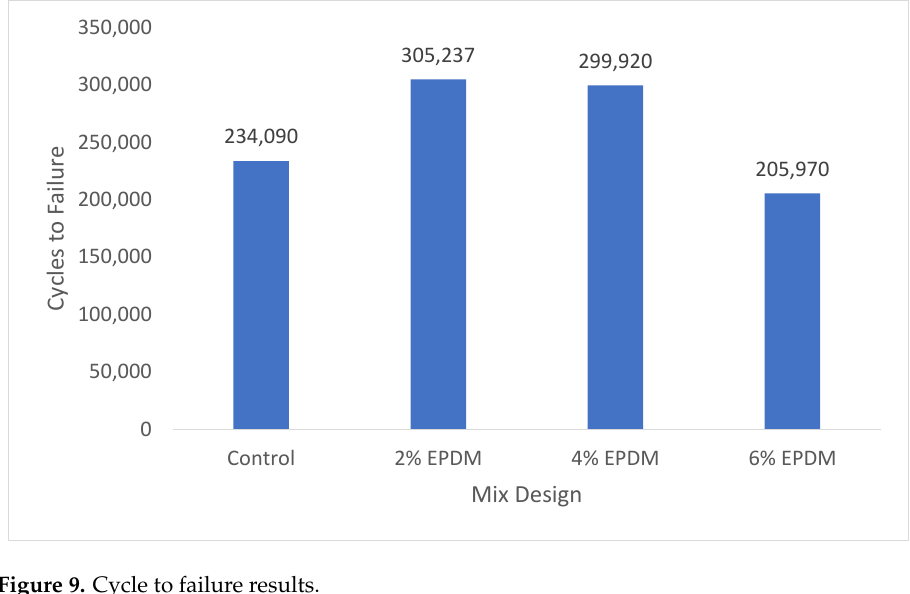
Figure 9. Cycle to failure results.